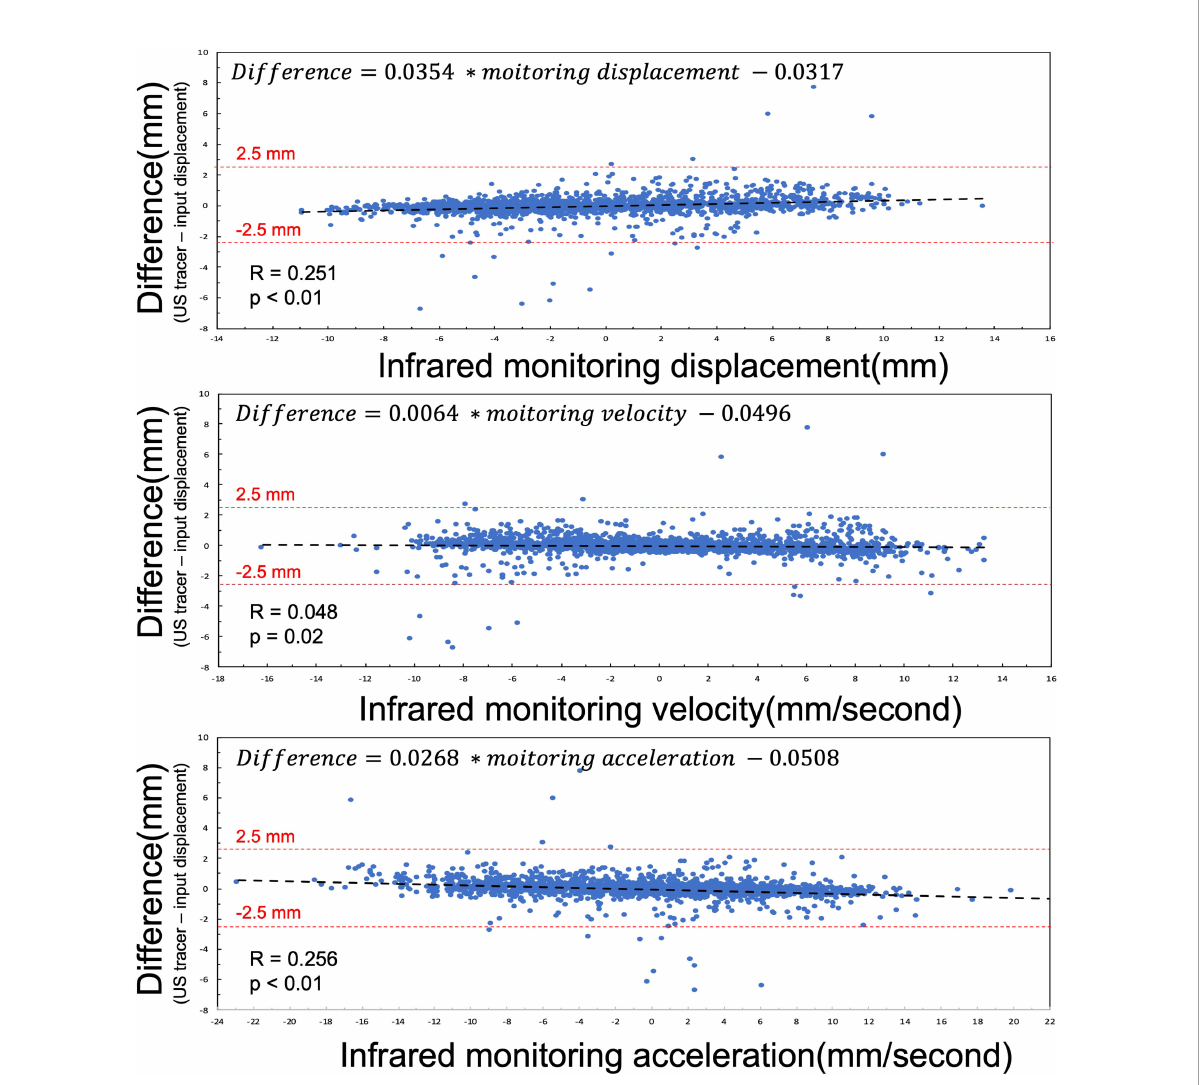
FIGURE 4 Linear regression analysis between the difference (the difference = US tracking displacement – input displacement) and infrared monitoring motion, infrared monitoring velocity, and infrared monitoring acceleration. The red dash lines represent criterion to estimate tracking